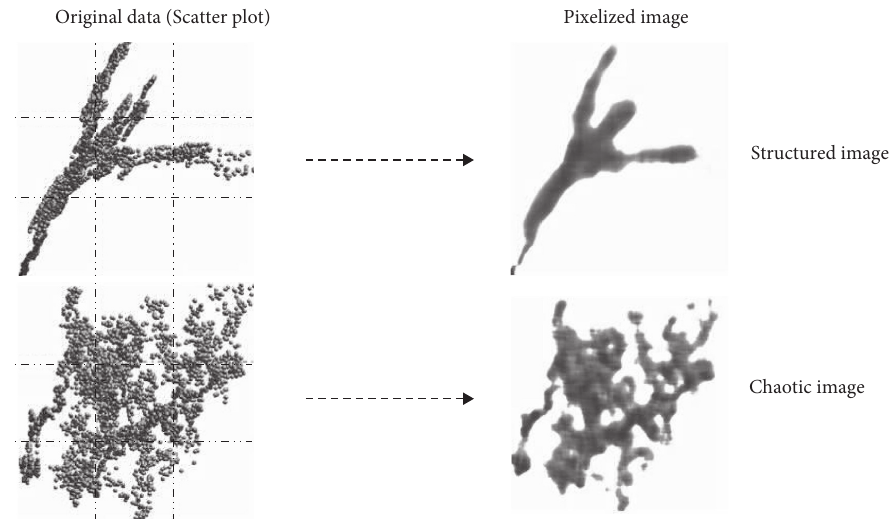
Figure 1: Examples of scatter plots and corresponding images. Images were obtained by subdividing the area of a scatter plot into pixels. The intensity of each pixel is proportional to the number of data points falling into it. Linear correlation = 0.92